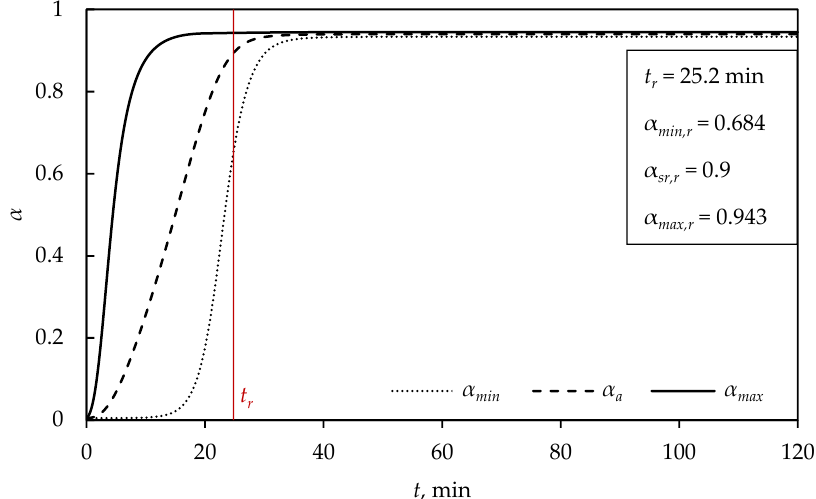
Figure 3. Dependence of the vulcanization degree on time for a sphere ( D = 5 cm) at T M = 150 °C. As the product surface was exposed to a constant temperature (150 °C), the maximal vulcanization degree on the surface rapidly reached the value of 0.9, and the minimal vulcanization degree reached a value of 0.9 only after removal from the mold (Figure